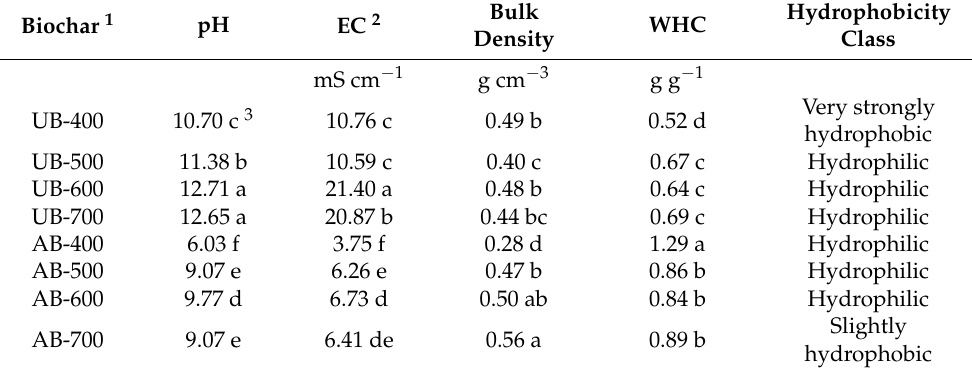
Table 2. Properties of biochar obtained from poultry litter at different temperatures (n = 3). Biochar 1